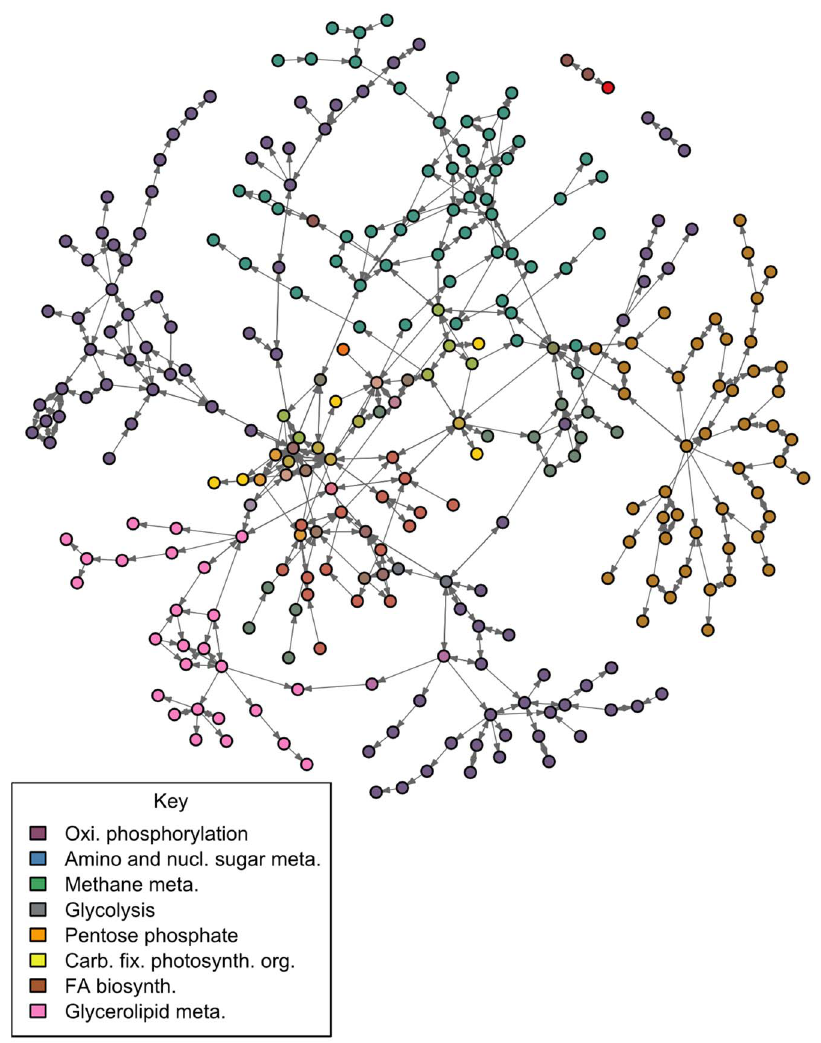
Figure 1. The graph of the significantly enriched pathways found using our GSEA method combined with the glycerolipid pathway. The full network contains 307 compounds and 558 reactions but compounds without reaction data were not drawn to reduce clutter. The graph is plotted with compounds drawn as nodes and reactions drawn as edges. The compounds are colored by their pathway membership; compounds belonging to 2 or more pathways are a mixture of the pathway colors. There were 7 compounds belonging to three pathways, 15 compounds belonging to two pathways and 117 compounds that were unique to their pathway. Many of the shared compounds are concentrated in the center of the graph and are related to glycolysis and pentose phosphate